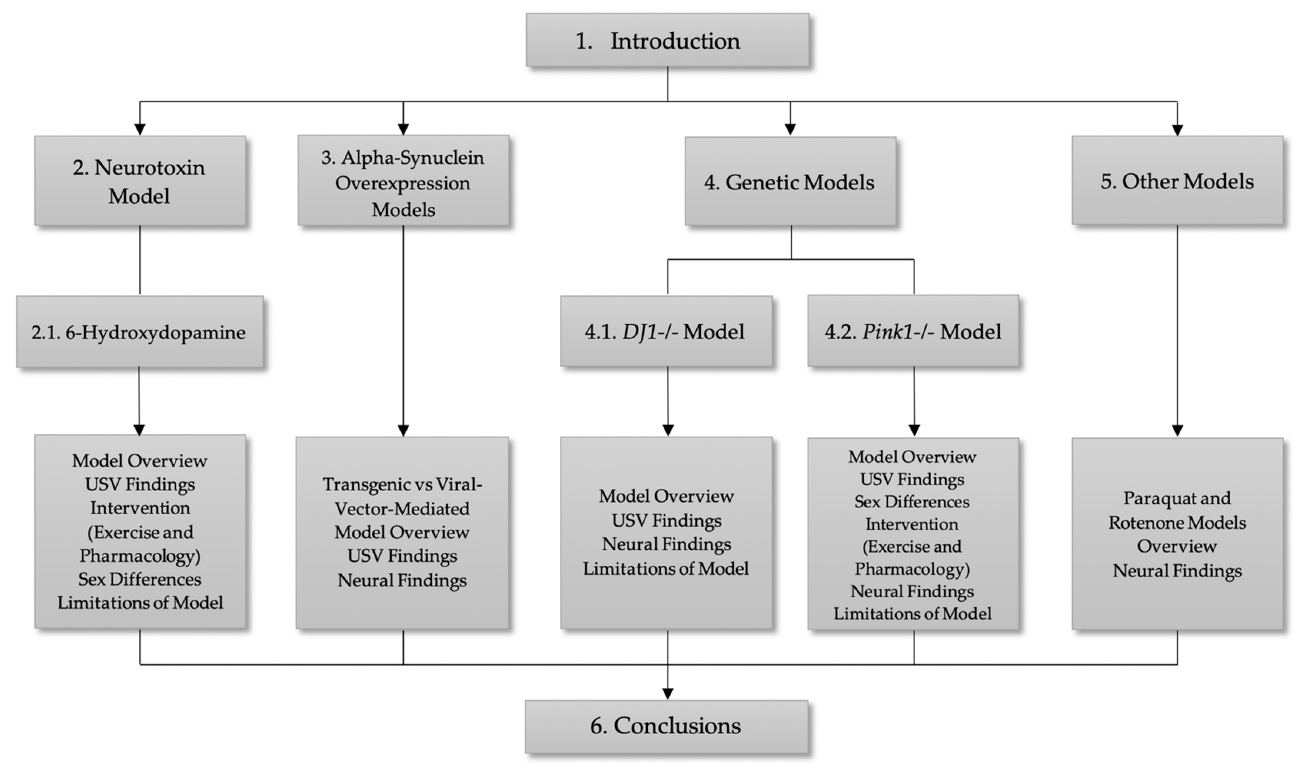
Figure 1. Manuscript overview.